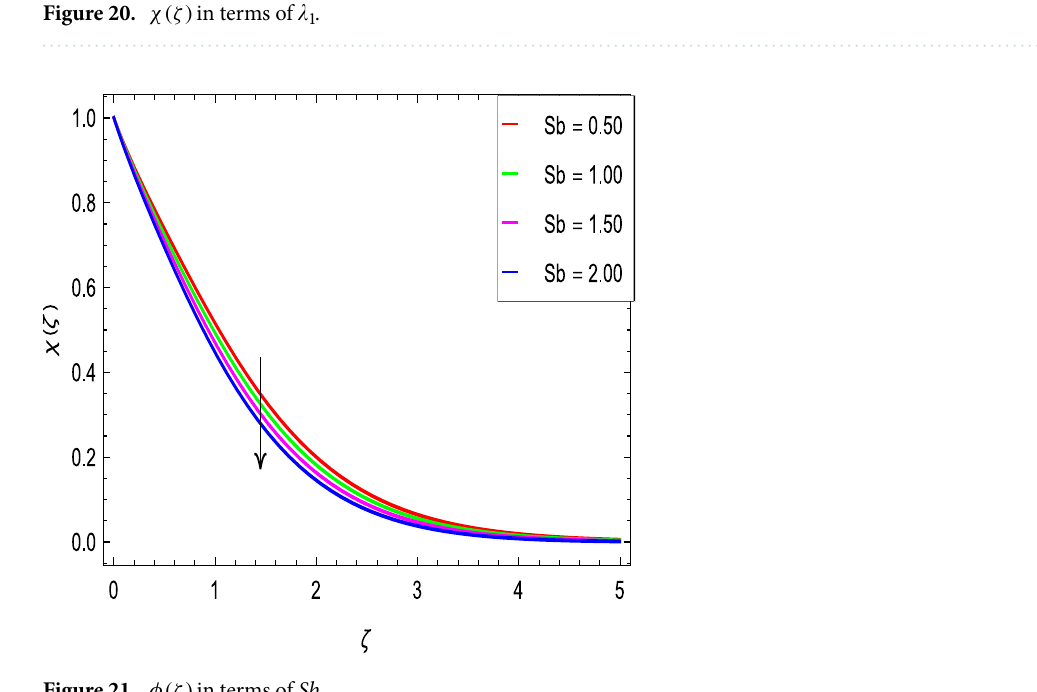
Figure 21. φ(ζ) in terms of Sb